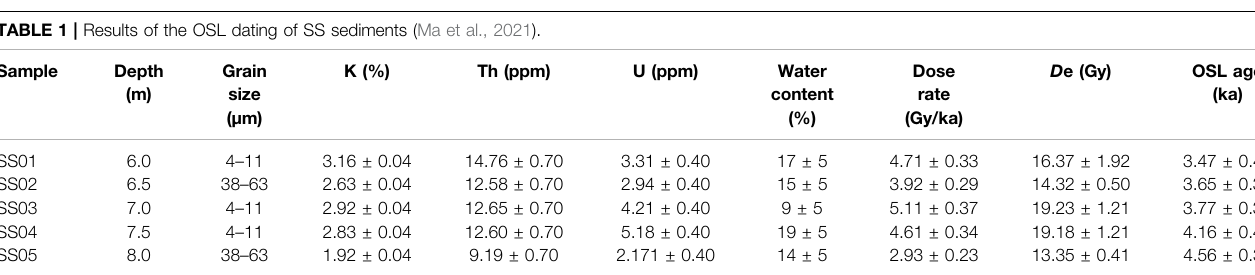
TABLE 1 | Results of the OSL dating of SS sediments (Ma et al., 2021).